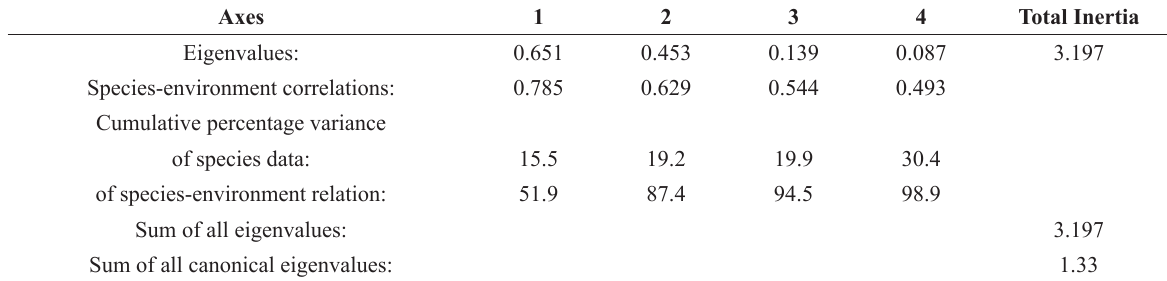
Result from canonical correspondence analysis (CCA) of 1946 cases of family occurrence in 526 collections from west tropical Atlantic